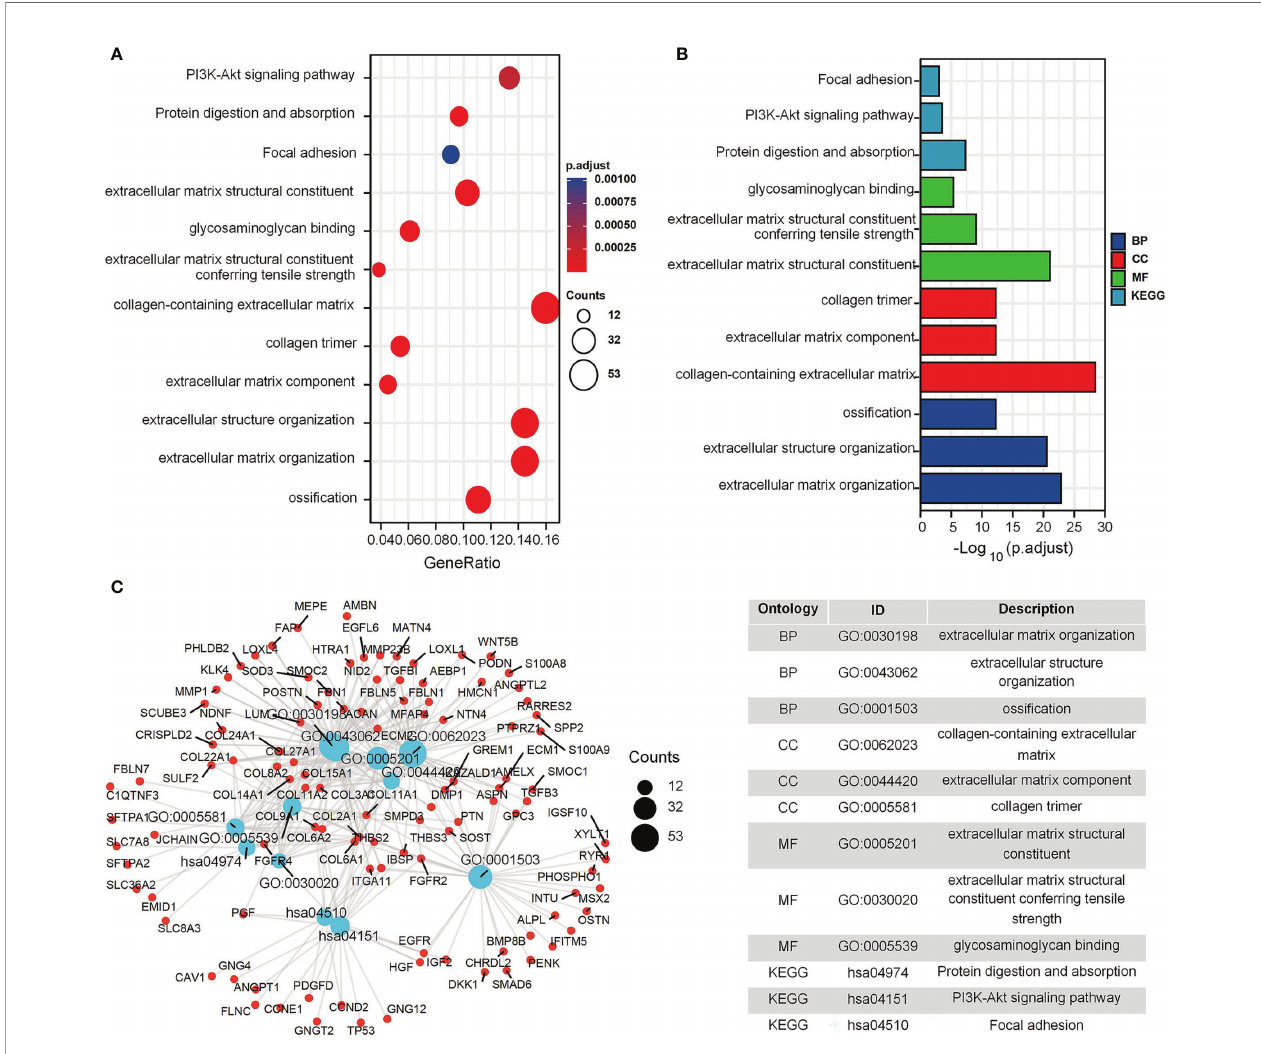
FIGURE 3 | GO and KEGG enrichment analysis in TARGET cohort. (A) The bubble graph of clusterPro fi ler package for GO and KEGG enrichment analysis; the bubble size represents the number of gene enrichment, and color represents signi fi cance in TARGET data set. (B) The bar graph of clusterPro fi ler package for GO and KEGG enrichment analysis; length represents signi fi cance in TARGET data set. (C) A function enrichment network in TARGET data